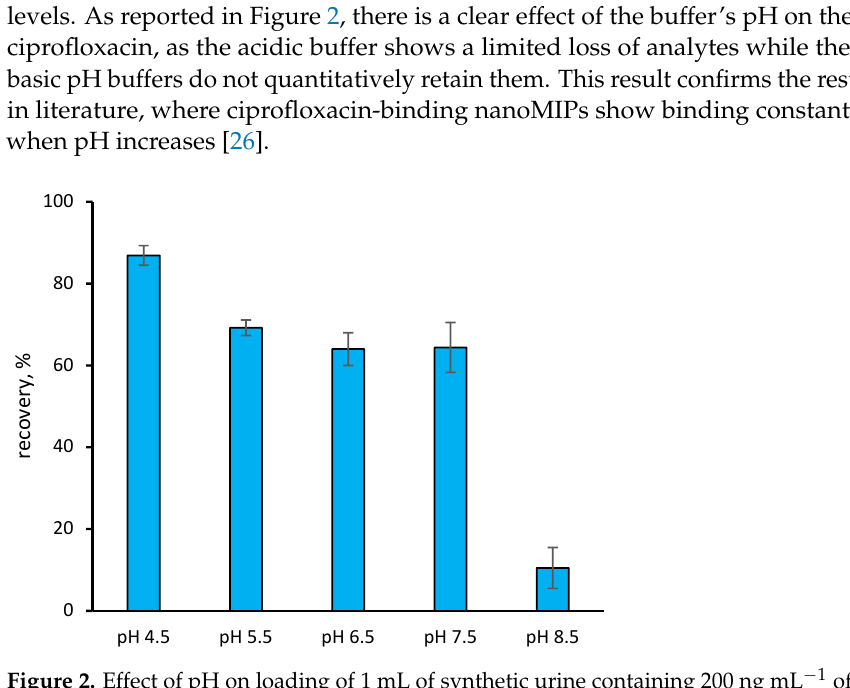
Figure 2. Effect of pH on loading of 1 mL of synthetic urine containing 200 ng mL − 1 of ciprofloxacin, diluted 9 + 1 v / v with 50 mmol L − 1 buffers.